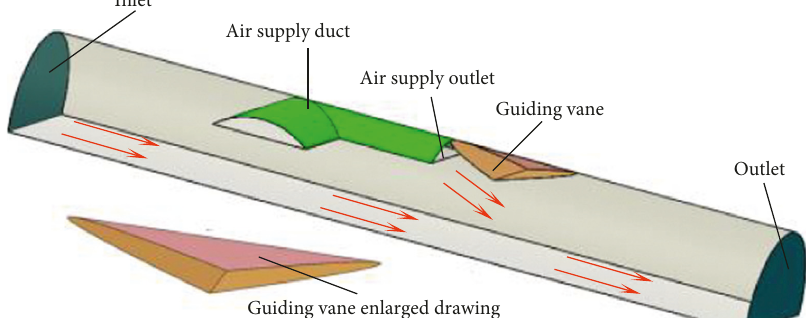
Figure 2: Schematic of installation of guiding vane in the local shaft blowing and exhausting longitudinal ventilation